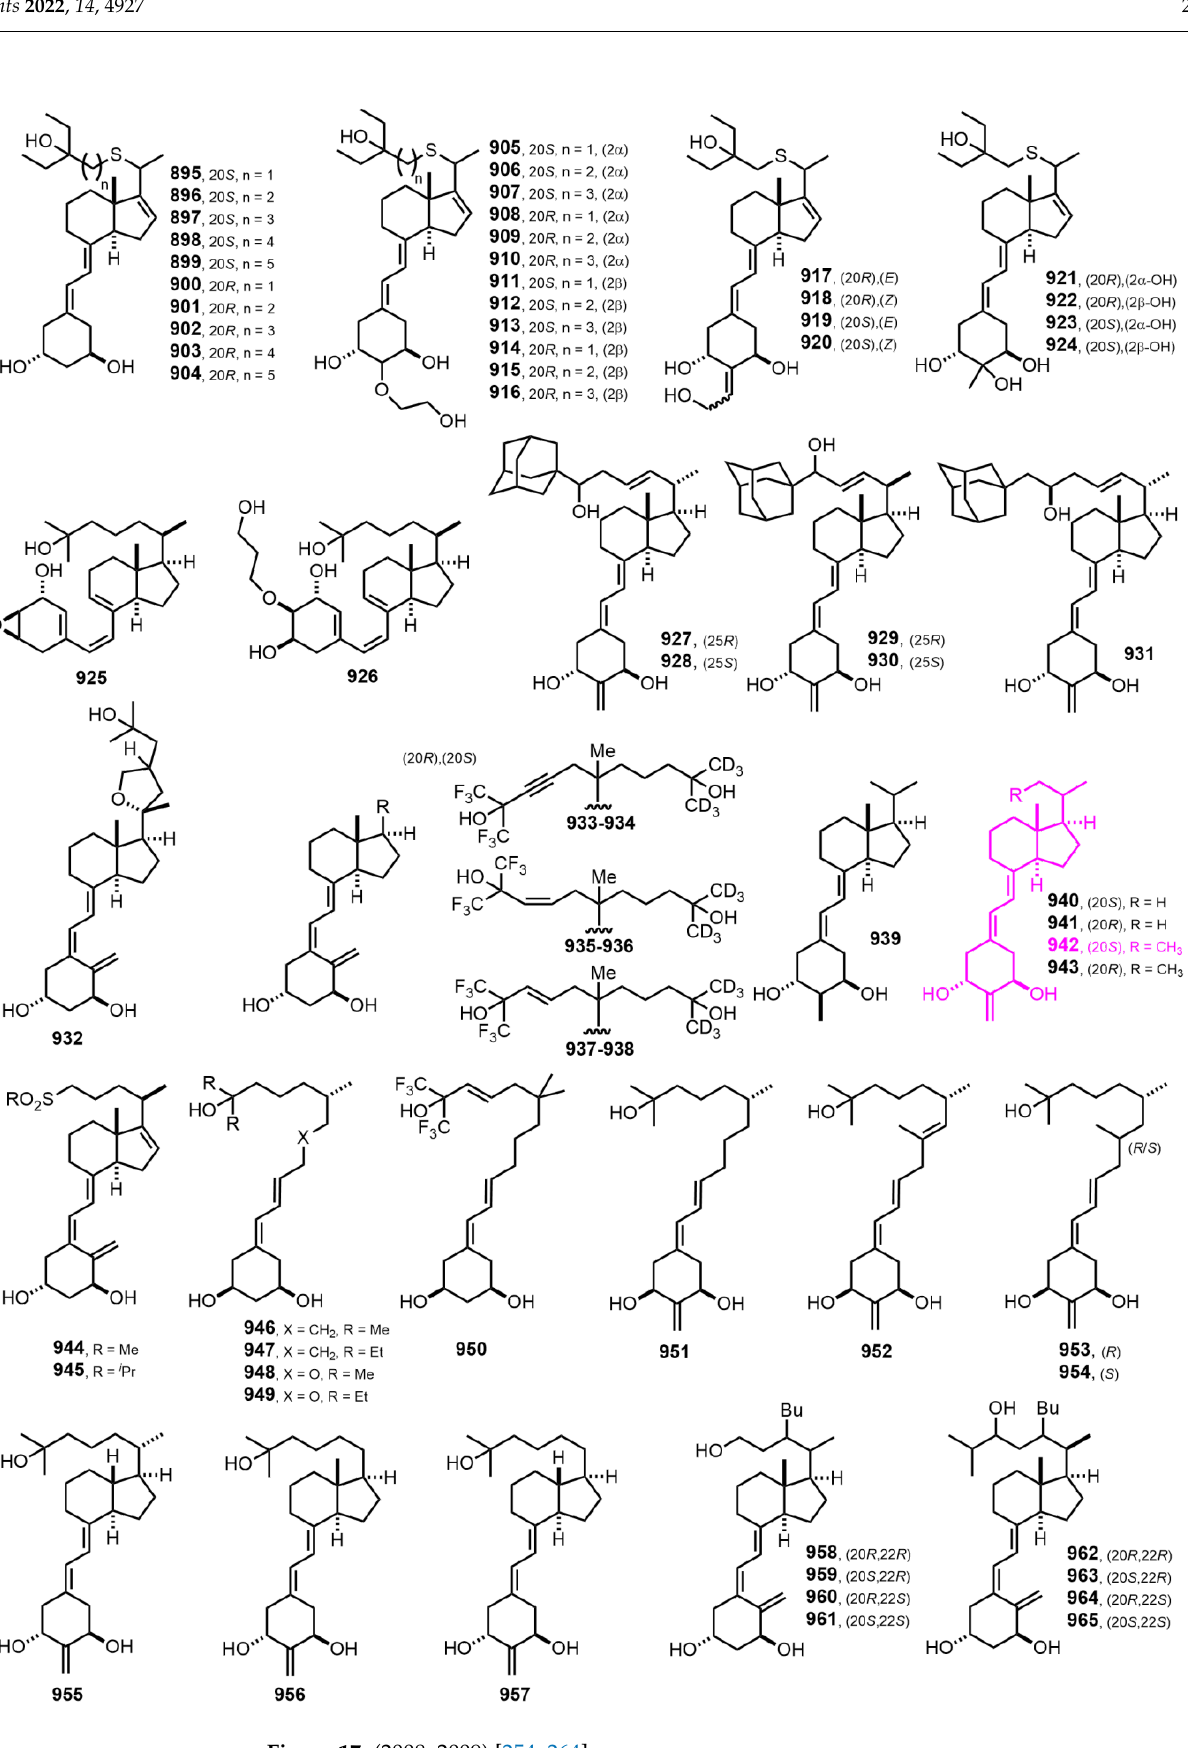
Figure 17. (2008-2009) [254 – 264].